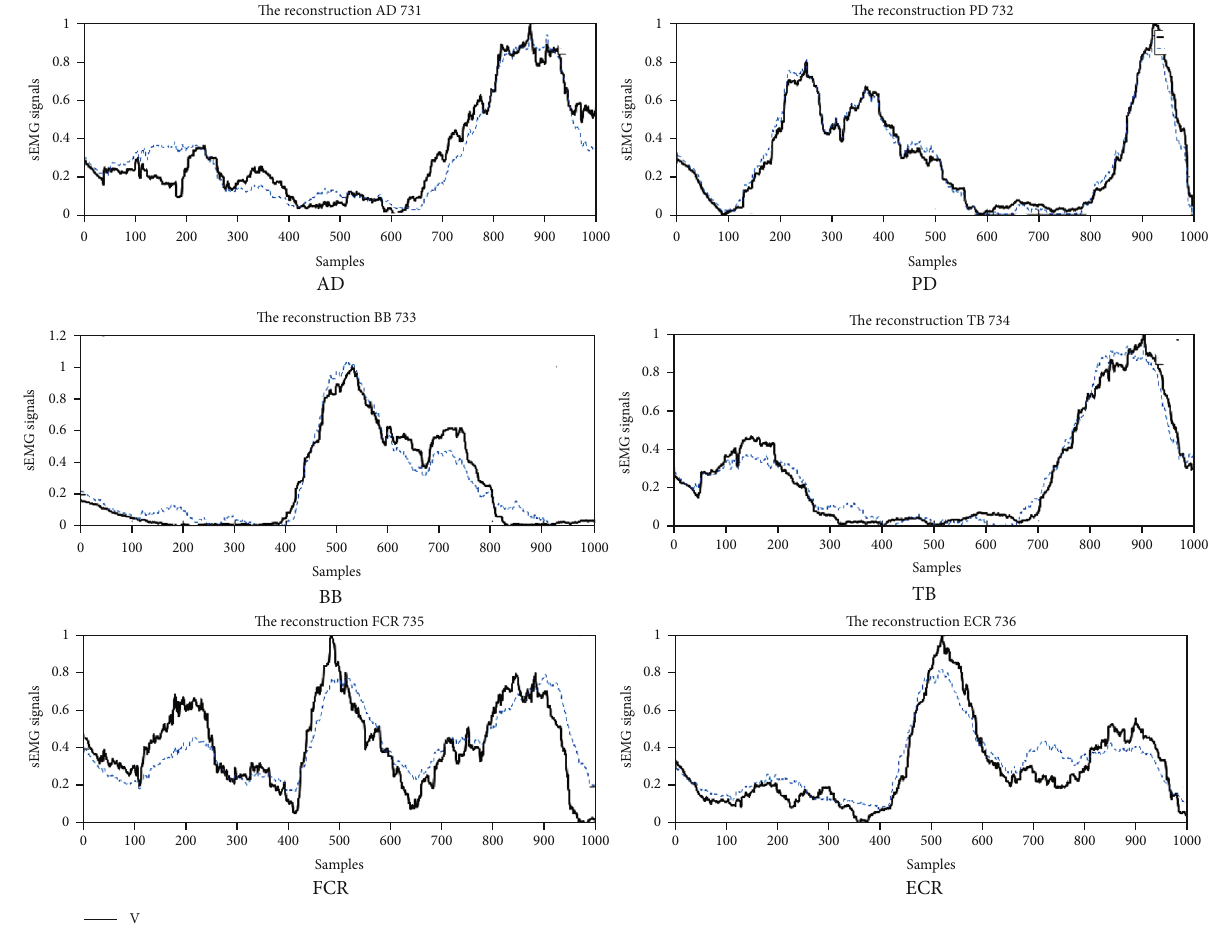
Figure 4: The comparison of raw and reconstructed sEMG data from factorized